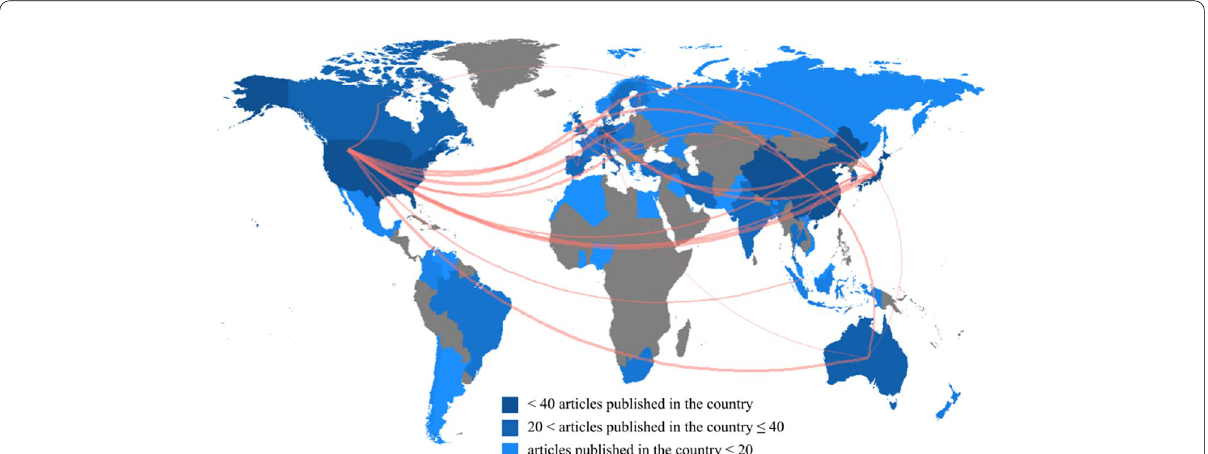
Fig. 6 Country collaboration map from the bibliometric analysis (1991–2020). Countries with considerable contribution colored from light to dark blue. Darker blue indicates higher number of publications, and red lines show collaboration between countries